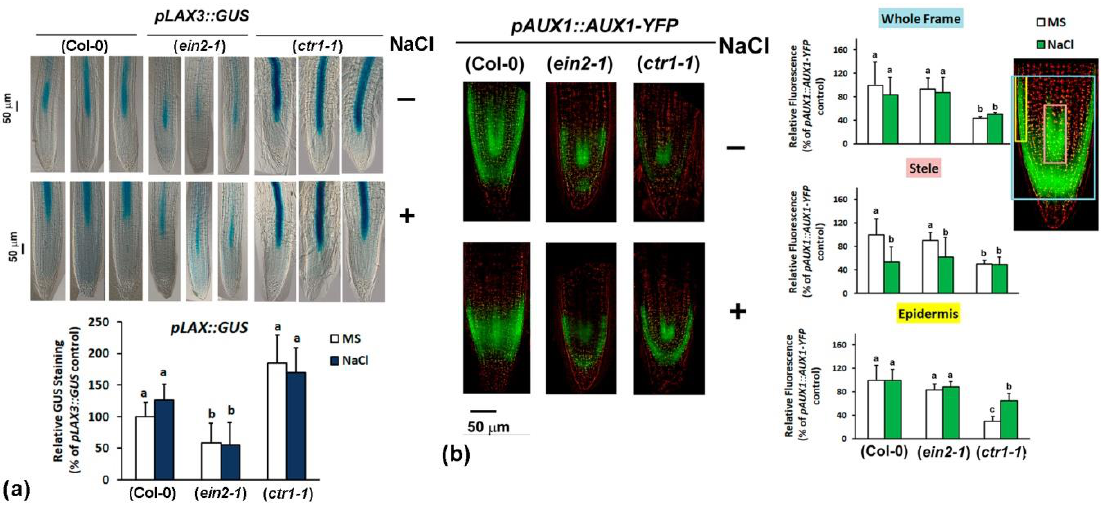
Figure 5. Auxin influx carrier expression in ethylene-signaling mutants subjected to treatment with 100 mM NaCl for 48 h: ( a ) GUS staining patterns and staining intensity measurement in roots of wild type Col-0 and homozygous F3 mutant ctr1-1 and ein2-1 plants carrying pLAX3::GUS. Three representative root images per line and per treatment are shown to demonstrate the consistency of the identified staining patterns. ( b ) Fluorescence intensity measurements in roots of pAUX1::AUX1-YFP reporters and their crosses with ctr1-1 and ein2-1 (homozygous F3 plants). The whole frame, stele, and epidermis macros used for the measurements are depicted on the root tip image in blue, pink and yellow, respectively. The letters in the graphs reflect significant differences in the different treatment groups found by comparison to the wild type background control (One-way ANOVA, p ≤ 0.05, and n ≥ 3 datasets from independent crosses).